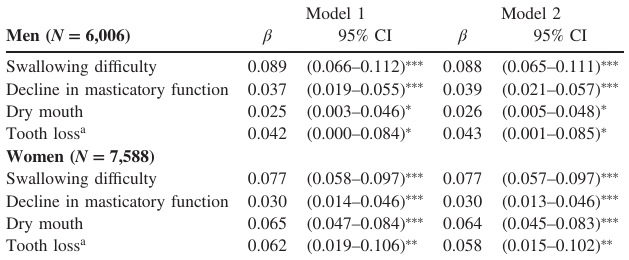
CI, con fi dence interval. Model 1: Swallowing di ffi culty, decline in masticatory function, dry mouth and tooth loss were separately included in the models with age. Model 2: Model 1 + marital status, income, education level, hypertension, diabetes mellitus, drinking history, smoking history, and walking time. a Reference category: ≥ 20. + P < 0.05. ++ P < 0.01. +++ P <